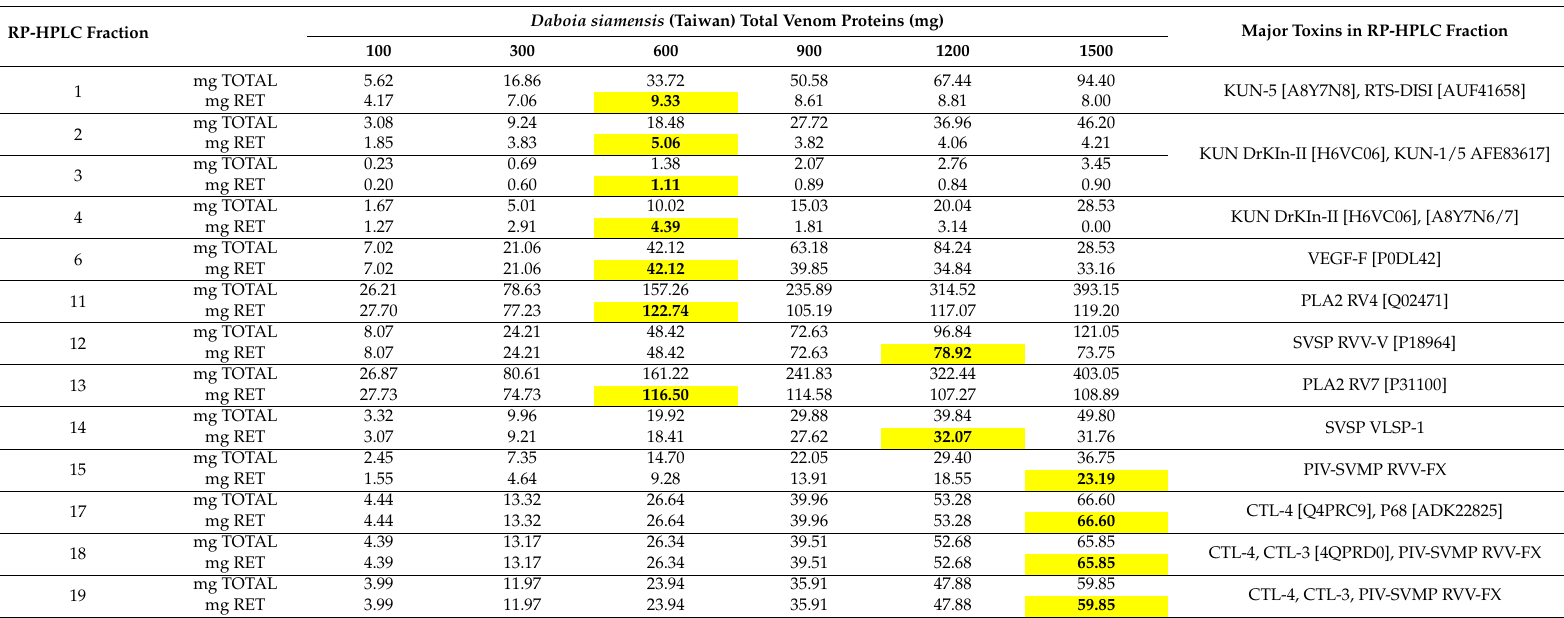
Table 2. Total and concentration-dependent immunoretained (RET) D. siamensis (Taiwan) venom proteins by CDC antivenom affinity columns containing 7 mg